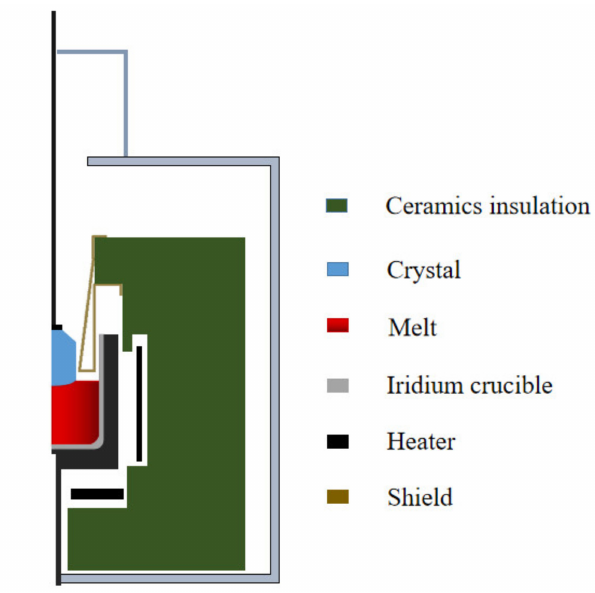
Figure 1. Scheme of the crystal growth